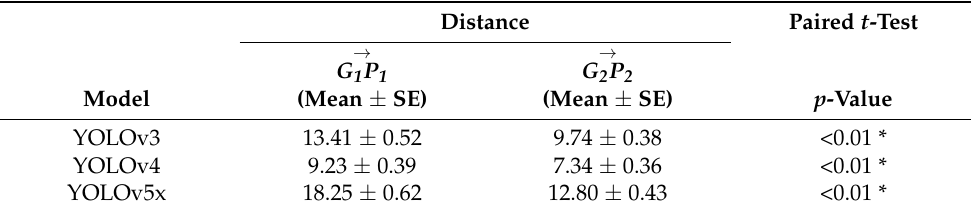
Figure 7. Comparisons of the front (𝑮 𝟏 𝑷 𝟏 ⃗⃗⃗⃗⃗⃗⃗⃗⃗⃗⃗⃗⃗ ) and rear of the foot axis point ( 𝑮 𝟐 𝑷 𝟐 ⃗⃗⃗⃗⃗⃗⃗⃗⃗⃗ ) of the angle-box on the distances between ground-truth and prediction points in different YOLO models. 𝑮 𝟏 𝑷 𝟏 ⃗⃗⃗⃗⃗⃗⃗⃗⃗⃗ , the distance between the front points of the ground-truth ( G 1 ) and YOLO model prediction ( P 1 ); 𝑮 𝟐 𝑷 𝟐 ⃗⃗⃗⃗⃗⃗⃗⃗⃗⃗ , the distance between the rear points of the ground-truth ( G 2 ) and YOLO model prediction ( P 2 ); *, a significant difference ( p < 0.01). Table 4. Effect of different points of FPA on the distance between the ground-truth point and pre- diction point.